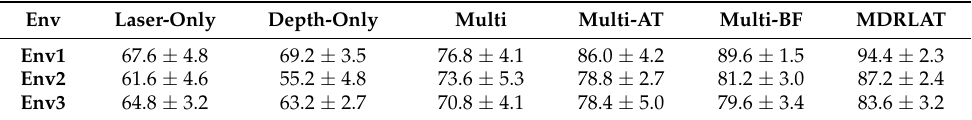
Table 2. Average success rate (%) and standard deviation obtained by different methods in three testing environments.